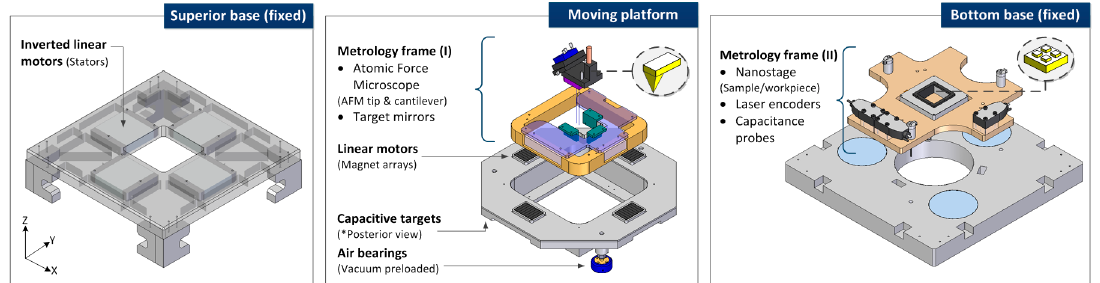
Figure 2. Detailed components view of the NanoPla three-layer main parts. ( Left ) Superior base; ( Middle ) Moving platform; ( Right ) Bottom base.